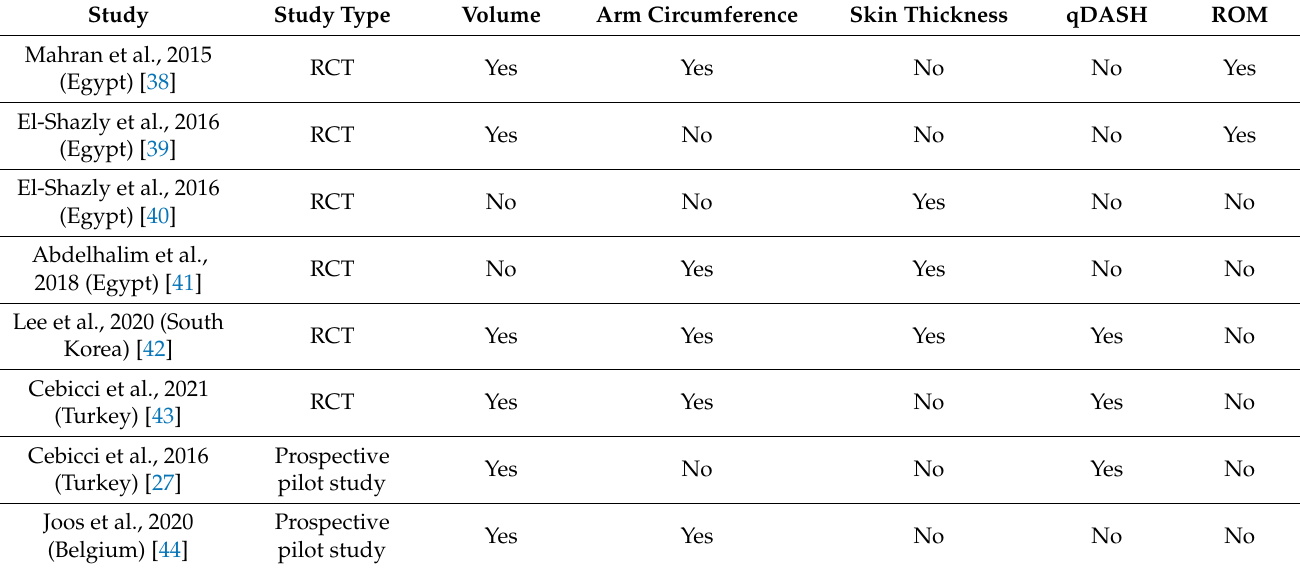
Table 4. Different methods were used to quantify symptoms of Breast cancer-related lymphedema in included trials. Volume Skin Thickness qDASH